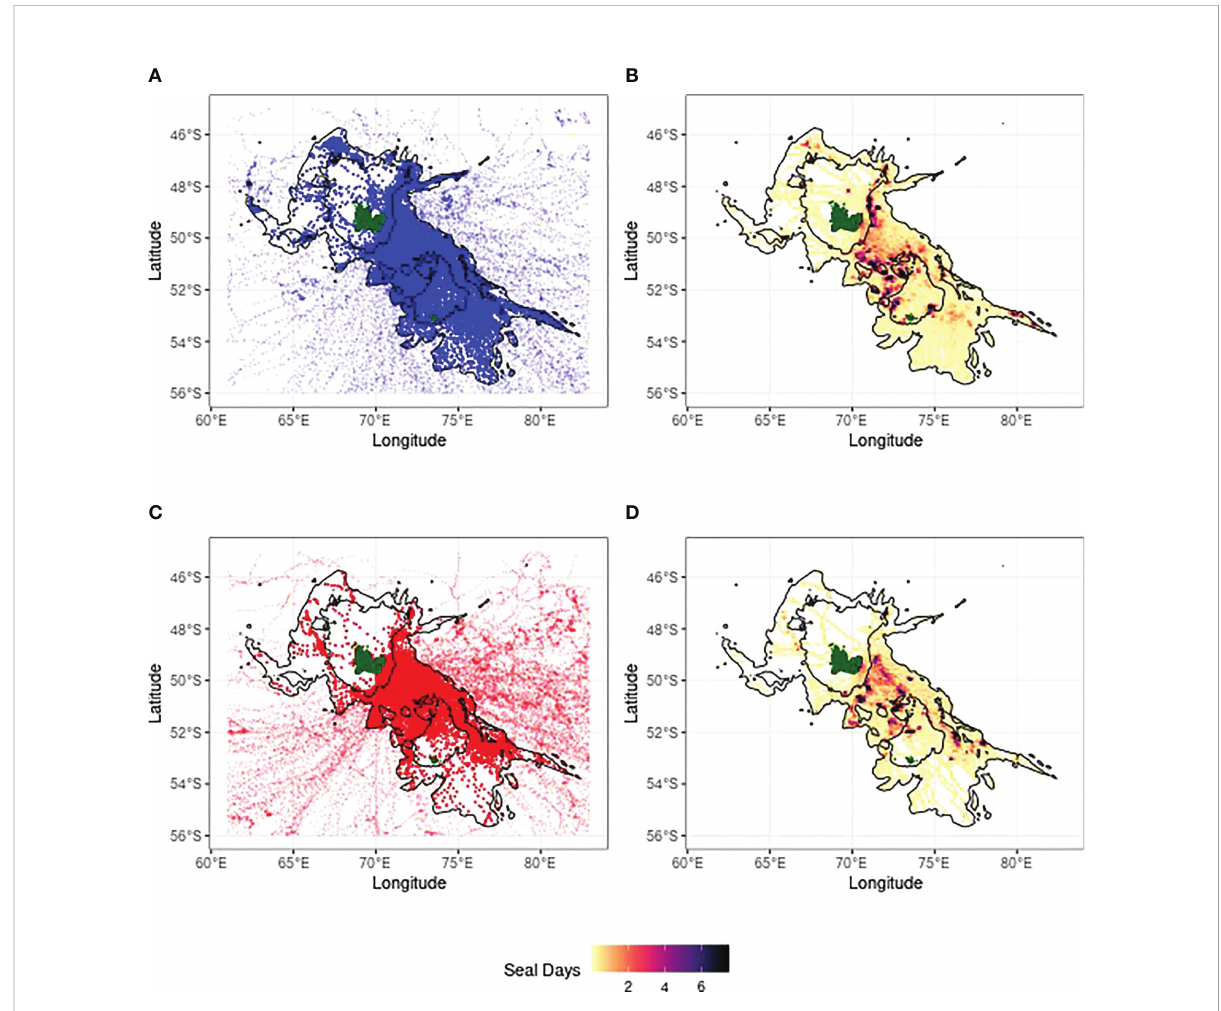
FIGURE 3 Distribution of male (blue, n=182) and female (red, n=156) post-molt elephant seals on the Kerguelen Plateau. (A, C) show those 6 hourly, state- space model-estimated locations that occurred within the overall study domain. (B, D) depict the utilization distribution, presented as seal days per 5x5 km cell, restricted to waters shallower than -2000m. The contours represent the -500 and -2000 m